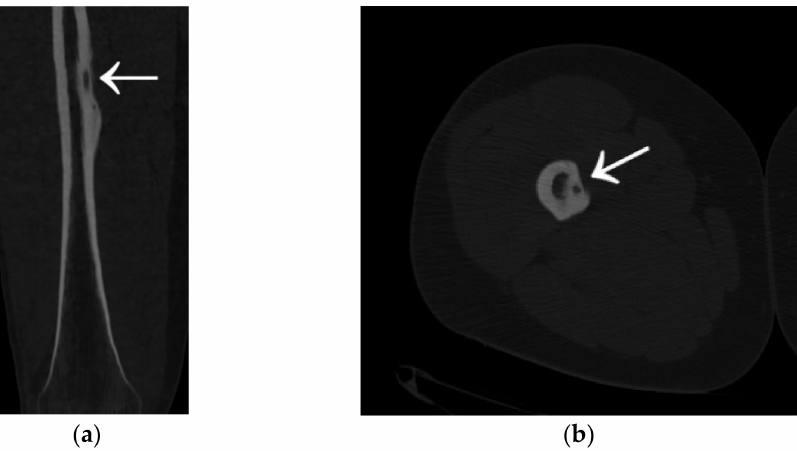
Figure 3. CT scans of the right femur showing flat cortical bone (arrows) after attempted resection and persistent focus of OO. ( a ) Frontal CT scan; ( b ) Transverse CT scan.